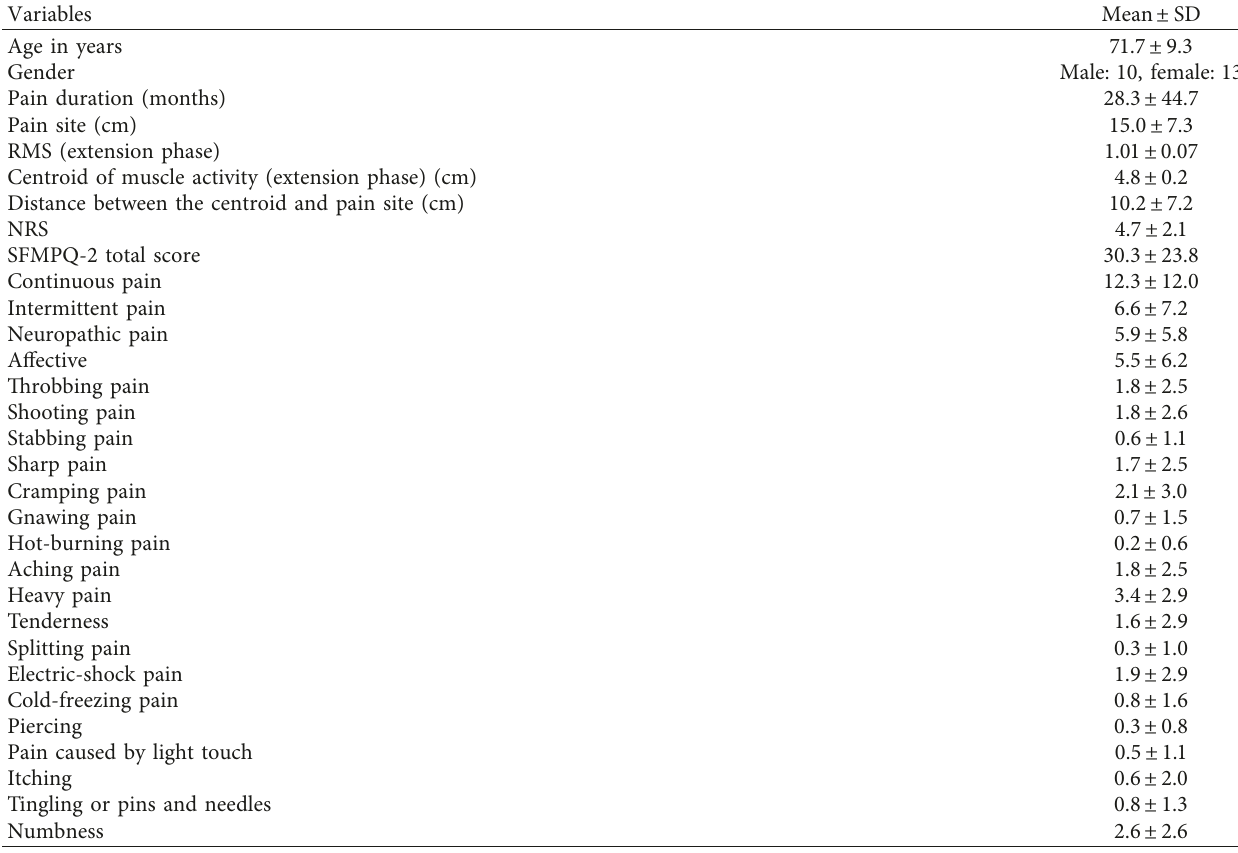
Table 1: Characteristics of the